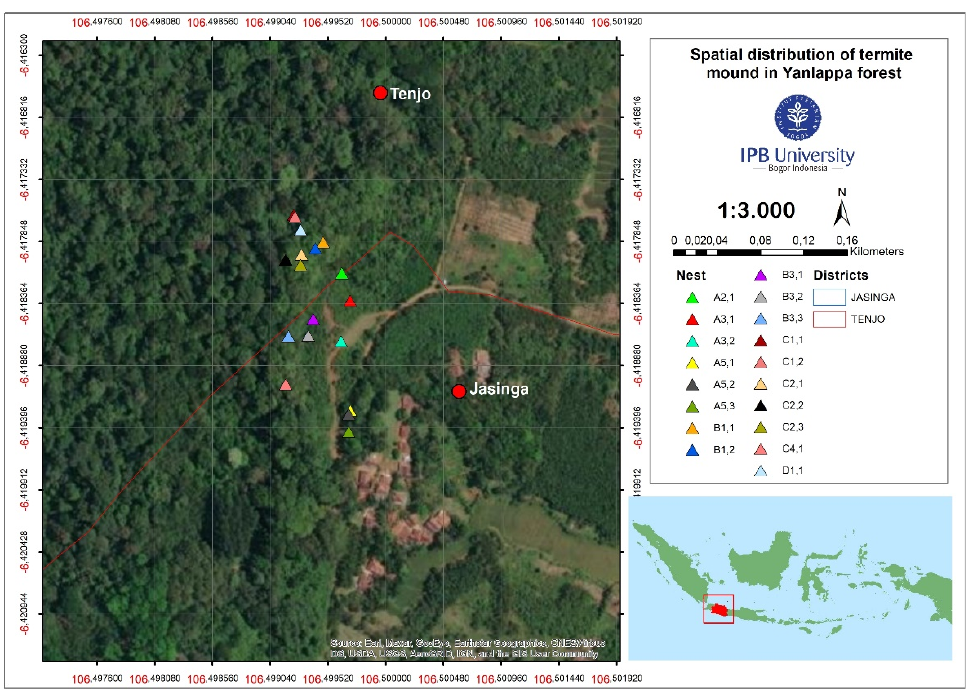
Figure 1. Spatial distribution of the eighteen M. gilvus mounds found in the Yanlappa Experimental Forest used as a source of fungus-comb samples.